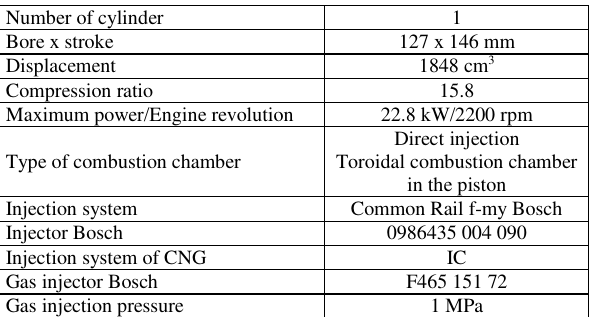
Fig. 1. General view of the test bed: a) engine test bed, b) view of the engine with assembled Common Rail system and with gas injectors on inlet manifold Table 1. Technical data of of SB3.1